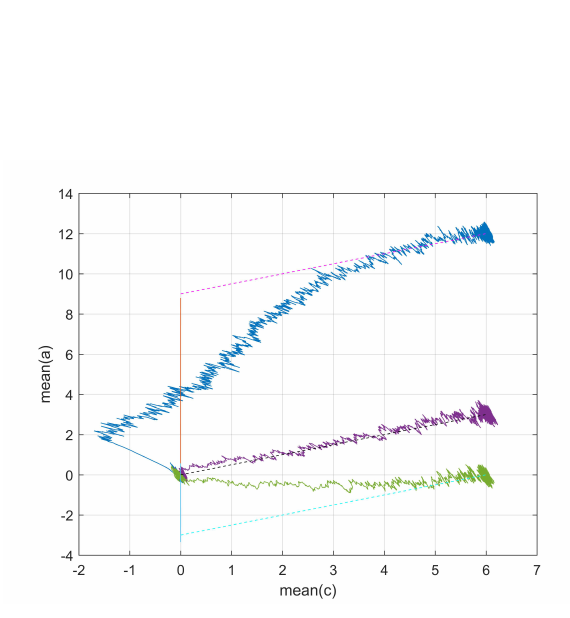
Figure 4: Step response phase plots corresponding to the step response plots in Figure 3, with G cc = 0 . 5 (blue) and G cc = 0 (ma- genta). Note that with G cc = 0 . 5, the point [ E [¯ c ] , E [¯ a ]] evolves from [0 , 0] to [6 , 12], such